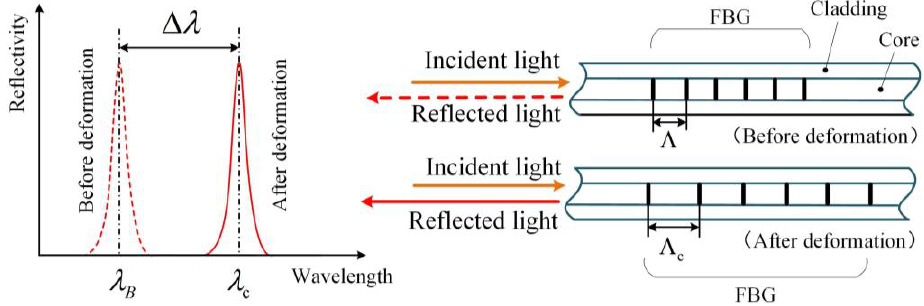
Figure 1. Structure and principle of the FBG.